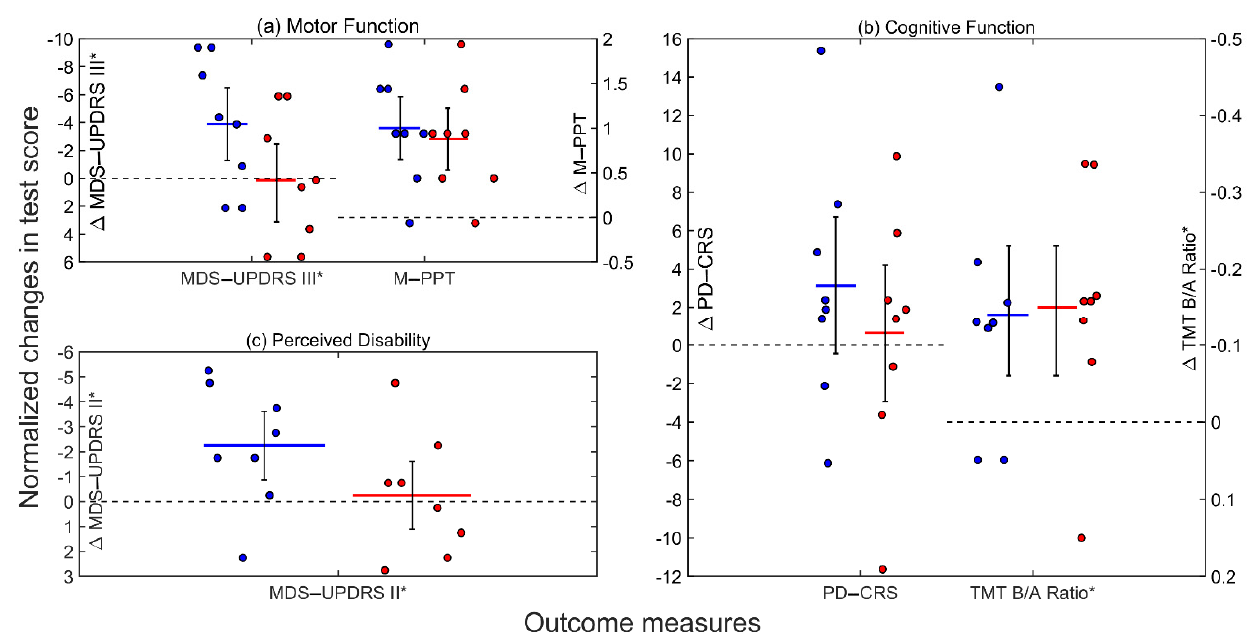
Figure 2. Comparison of individual normalized change scores (colored circles) and group means of normalized change scores (colored horizontal bars) between DTT and STT for five outcome measures. Whisker ends represent upper and lower bounds of 84% CIs for group means. Dashed horizontal lines represent no change in pre-post training scores; values above them indicate pre-post training improvements. * Negative values indicate score improvements for this outcome measure.